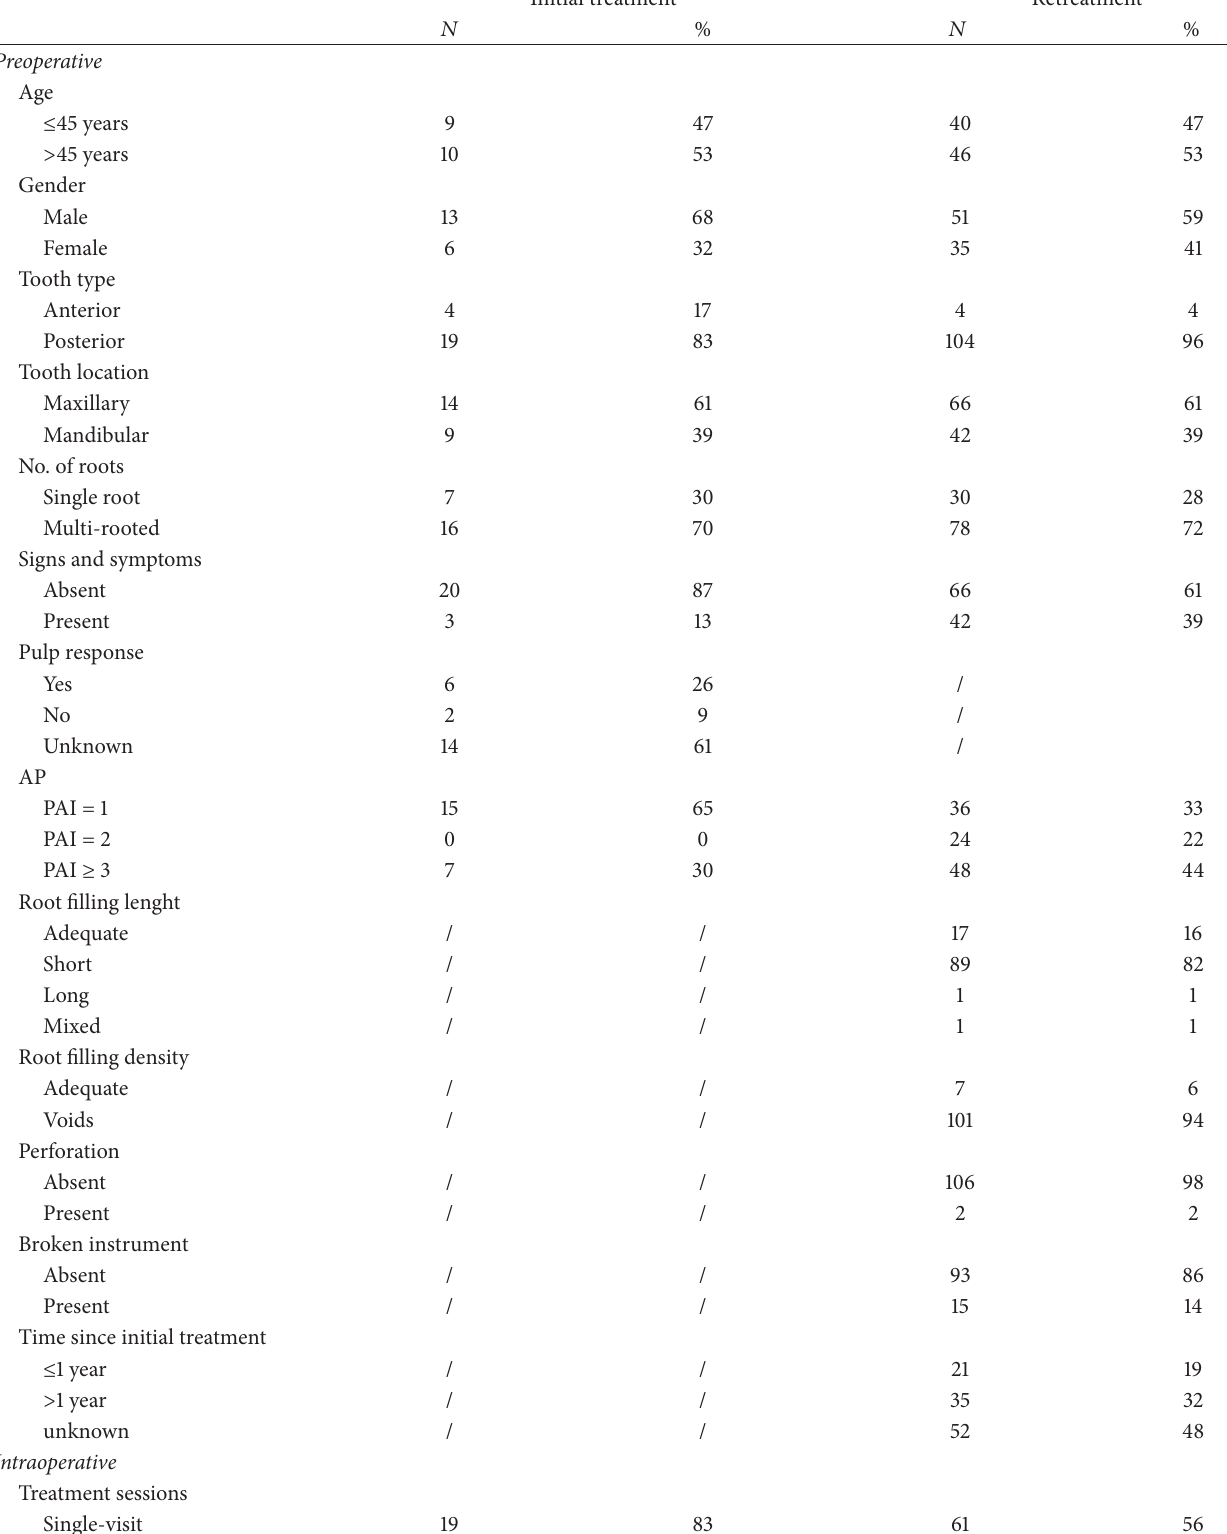
Table 1: Distribution of variables: preoperative, intraoperative, postoperative factors. Initial